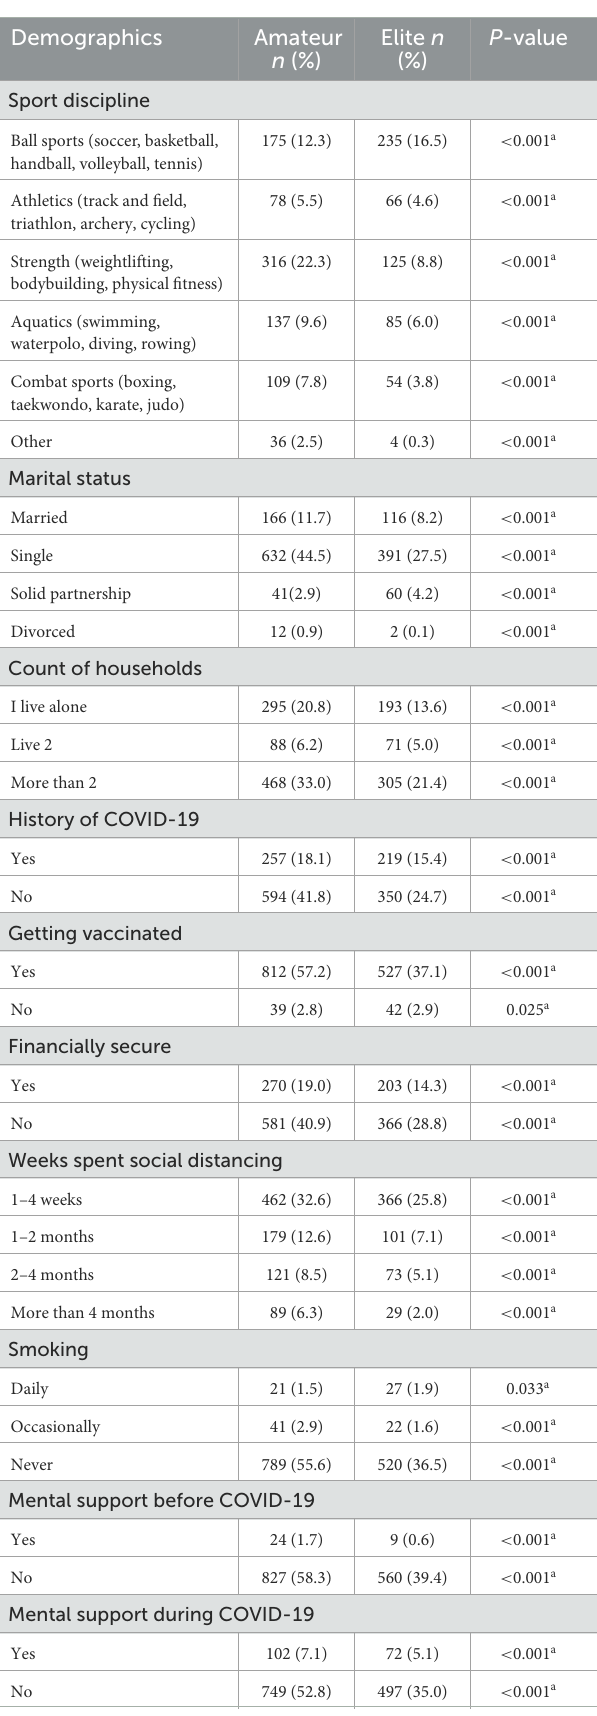
TABLE 1 Descriptive statistics of individual